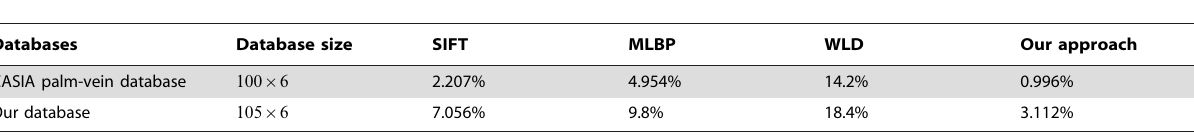
Table 2. Comparative experiments for two different databases.